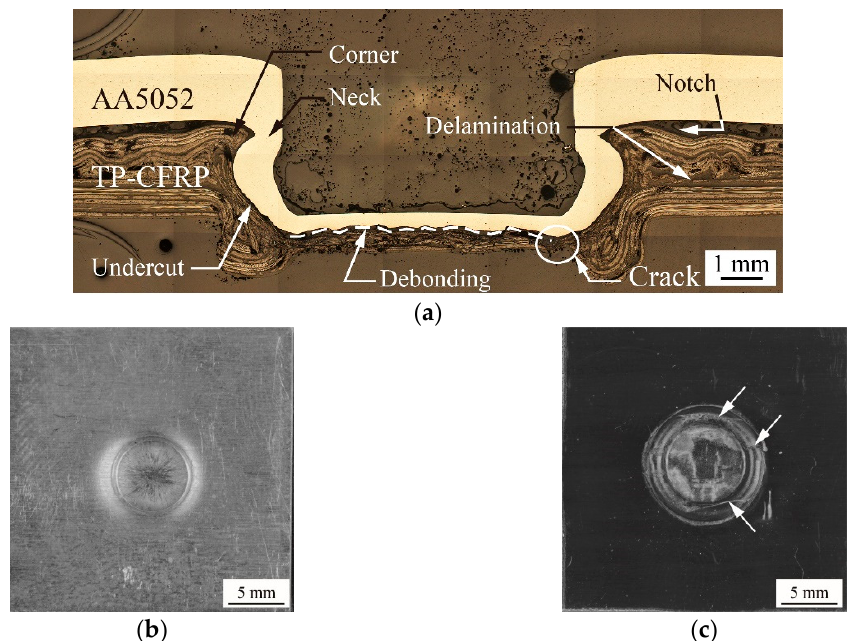
Figure 6. ( a ) A cross-sectional micrograph of an AA5052 / TP-CFRP dissimilar clinch joint. ( b ) The top and ( c ) the bottom views of another AA5052 / TP-CFRP dissimilar clinch joint.